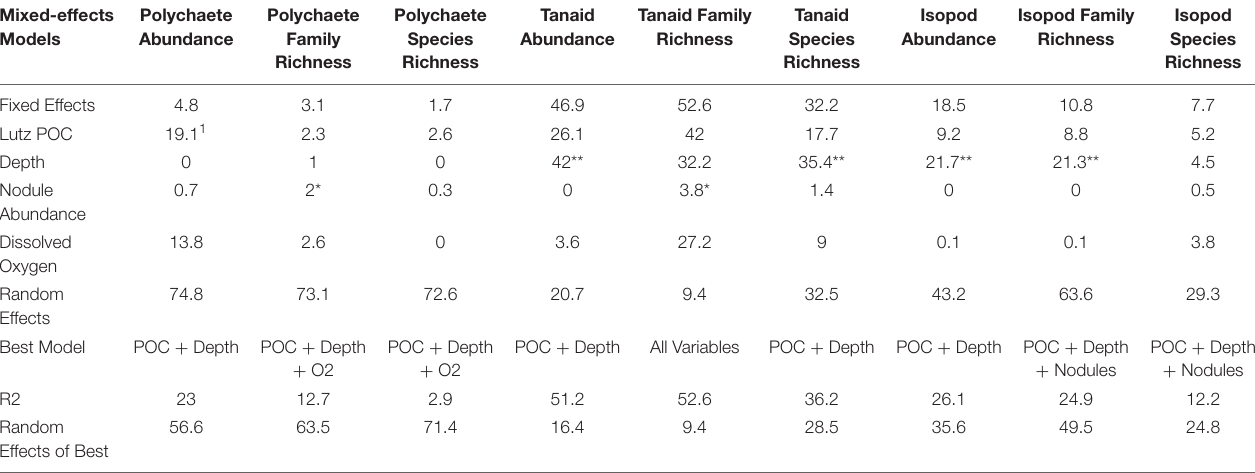
TABLE 2 | Results of linear mixed-effects models examining abundance, family richness, and species richness (taxa within a core) for polychaetes, tanaids, and isopods within the CCZ. Mixed-effects